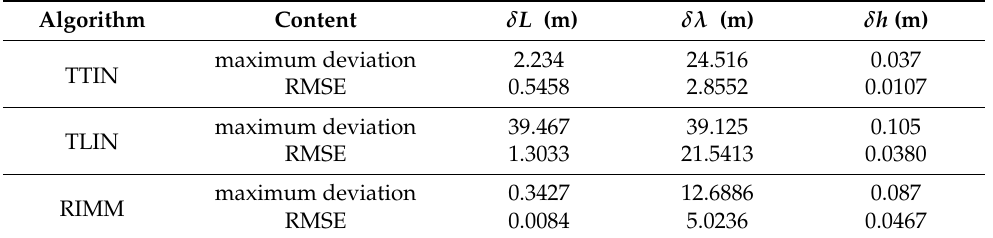
Table 6. Position error parameters for the three algorithms when DVL works in a complex